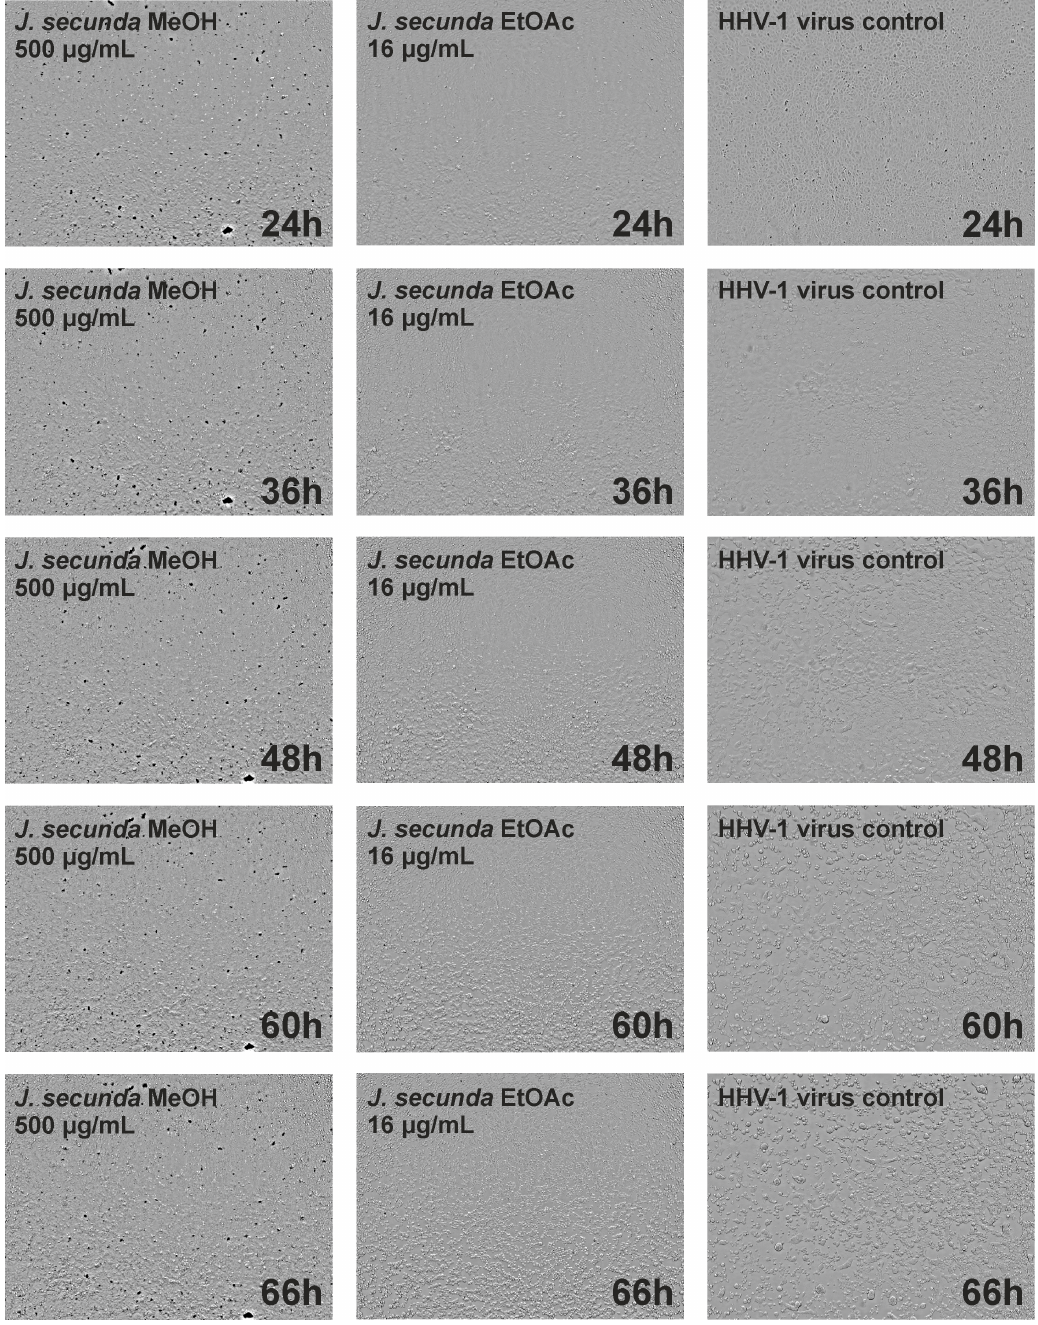
Figure 4. Real-time microscopic monitoring of the antiviral